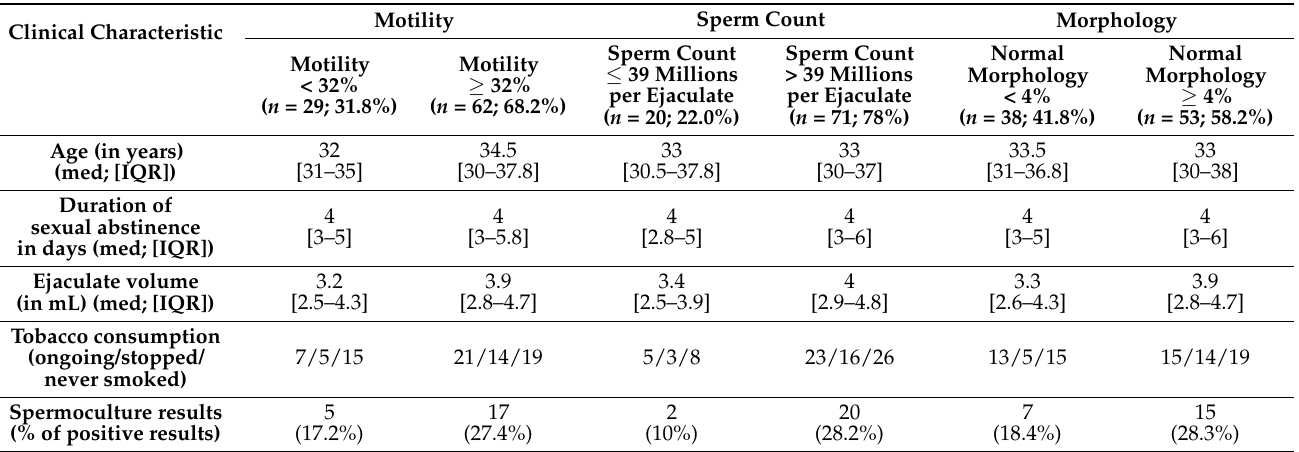
Figure 2. Comparison of alpha diversities, determined with different indexes (( A ) Chao1; ( B ) Shannon; ( C ) FaithPD) according to the “morphology” parameter. The comparison between groups with abnormal vs. normal morphology demonstrated significant difference (* p < 0.05). Table 1. Patients’ baseline characteristics according to sperm parameters: motility, sperm count, and morphology. No statistical association could be observed between sperm parameters and clinical characteristics in the present cohort ( p > 0.05).